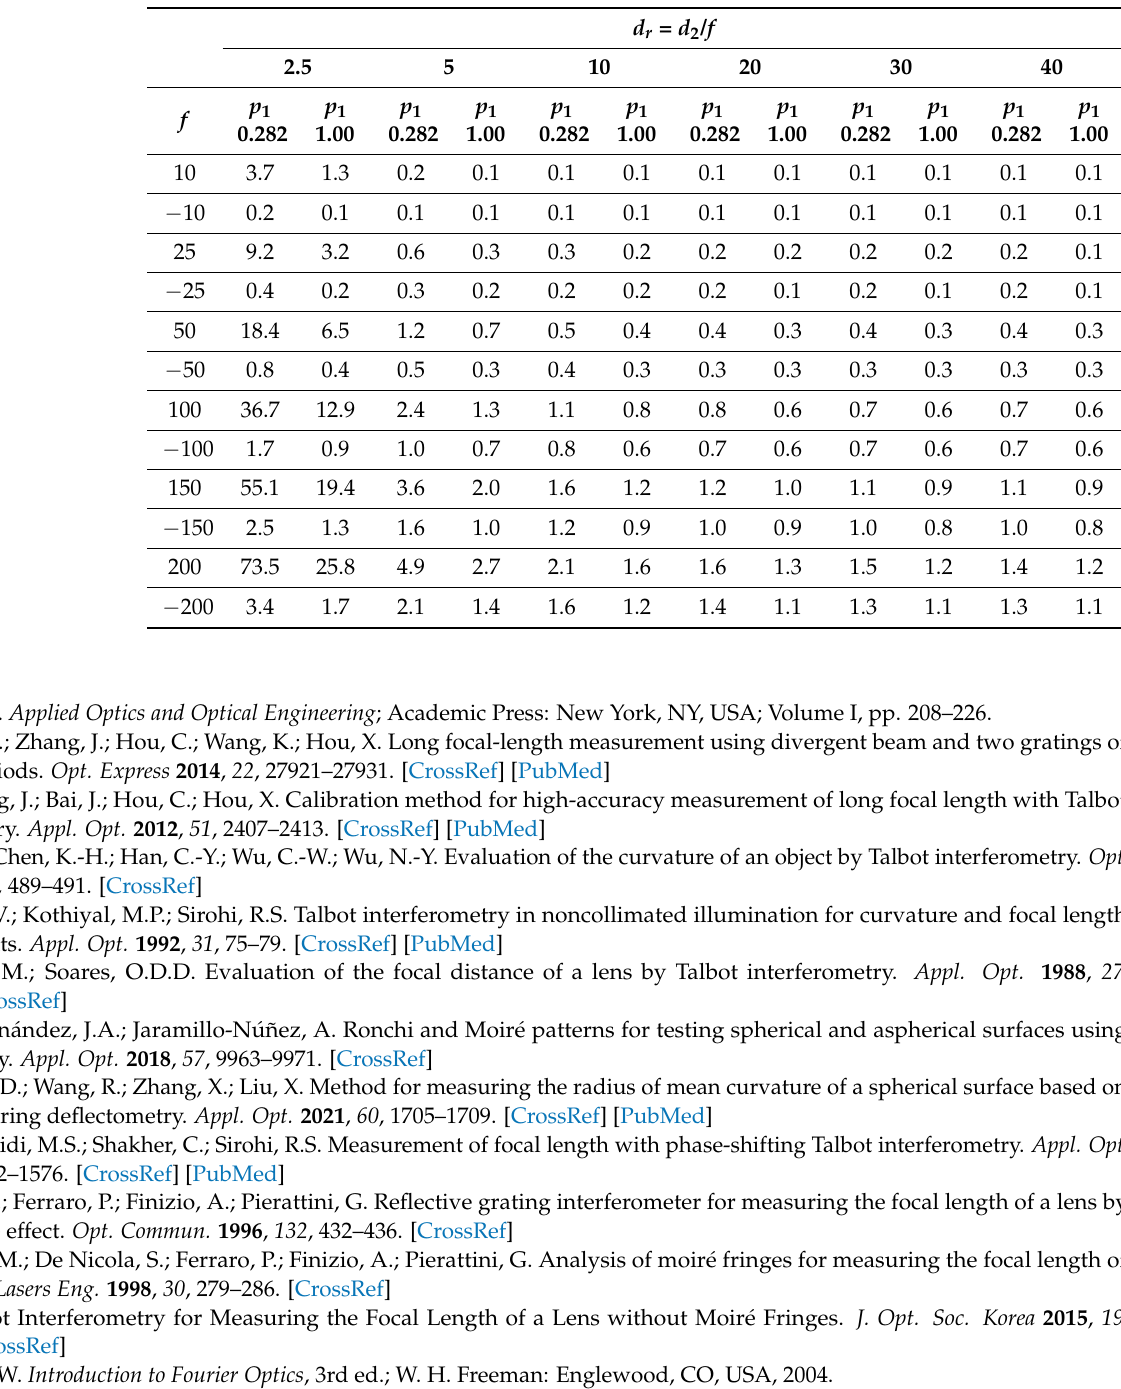
Table A1. Theoretical evaluation values (orthogonal arrays) for the measurement uncertainty of focal length (unit: mm) under different focal lengths, relative distances, and periods of grating